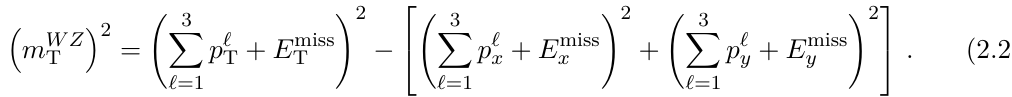
Figure 5 . The m 4 l distribution for q 4 ‘ ATLAS data from ref.